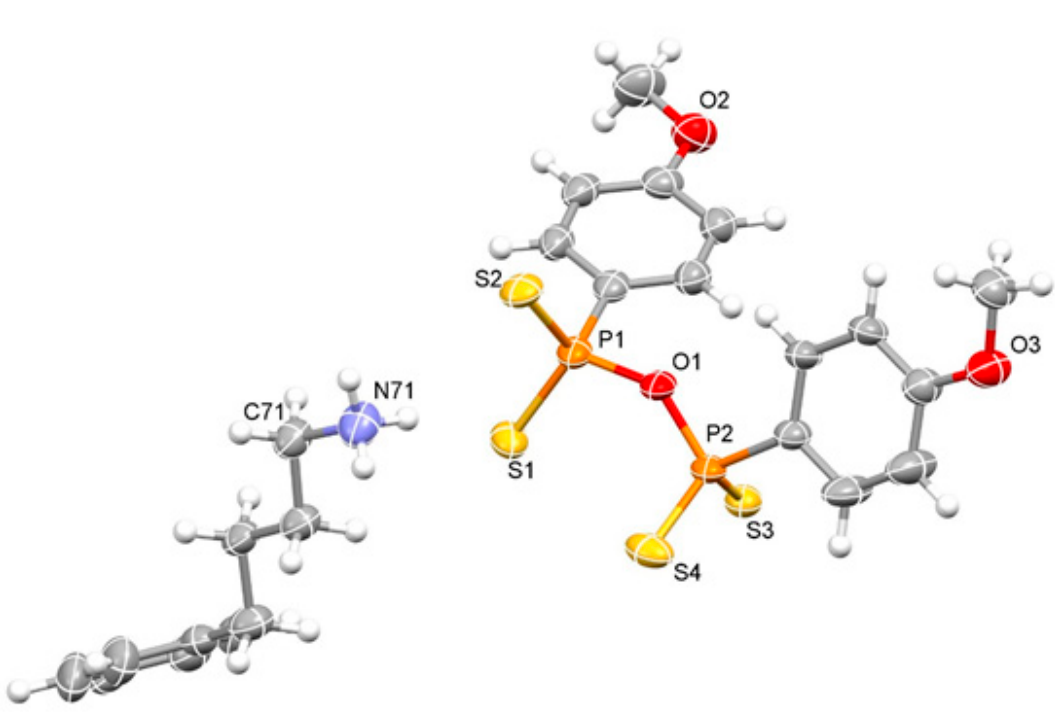
Figure 5. Ellipsoid plot (50% probability level) and numbering scheme of part of the asymmetric unit of (PhBuNH 3 ) 2 [(ArPS 2 ) 2 O].